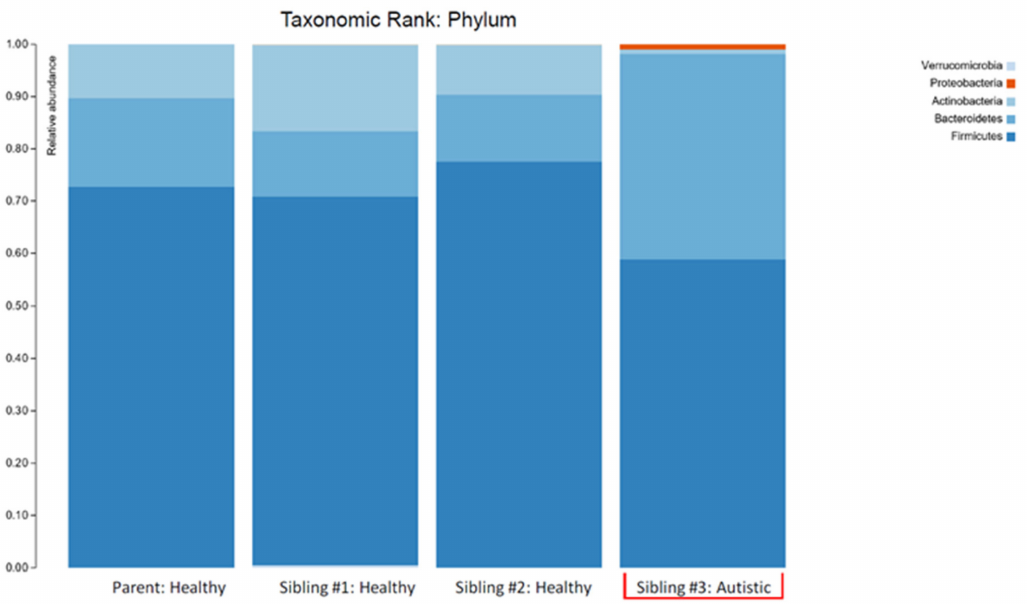
Figure 2. The stacked bar plots show the bacterial phyla composition in the gut microbiome of a patient with autism spectrum disorder (Sibling #3) and the patient’s healthy biological triplet siblings and